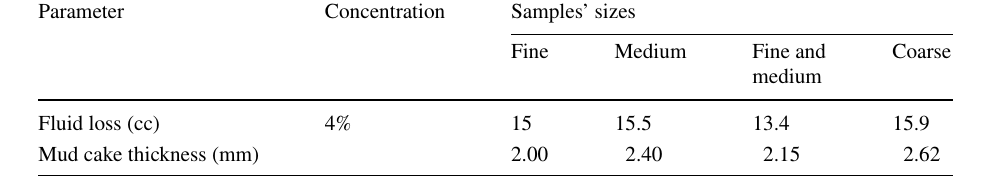
Table 6 Fluid loss and mud cake thickness results for base mud samples (nut